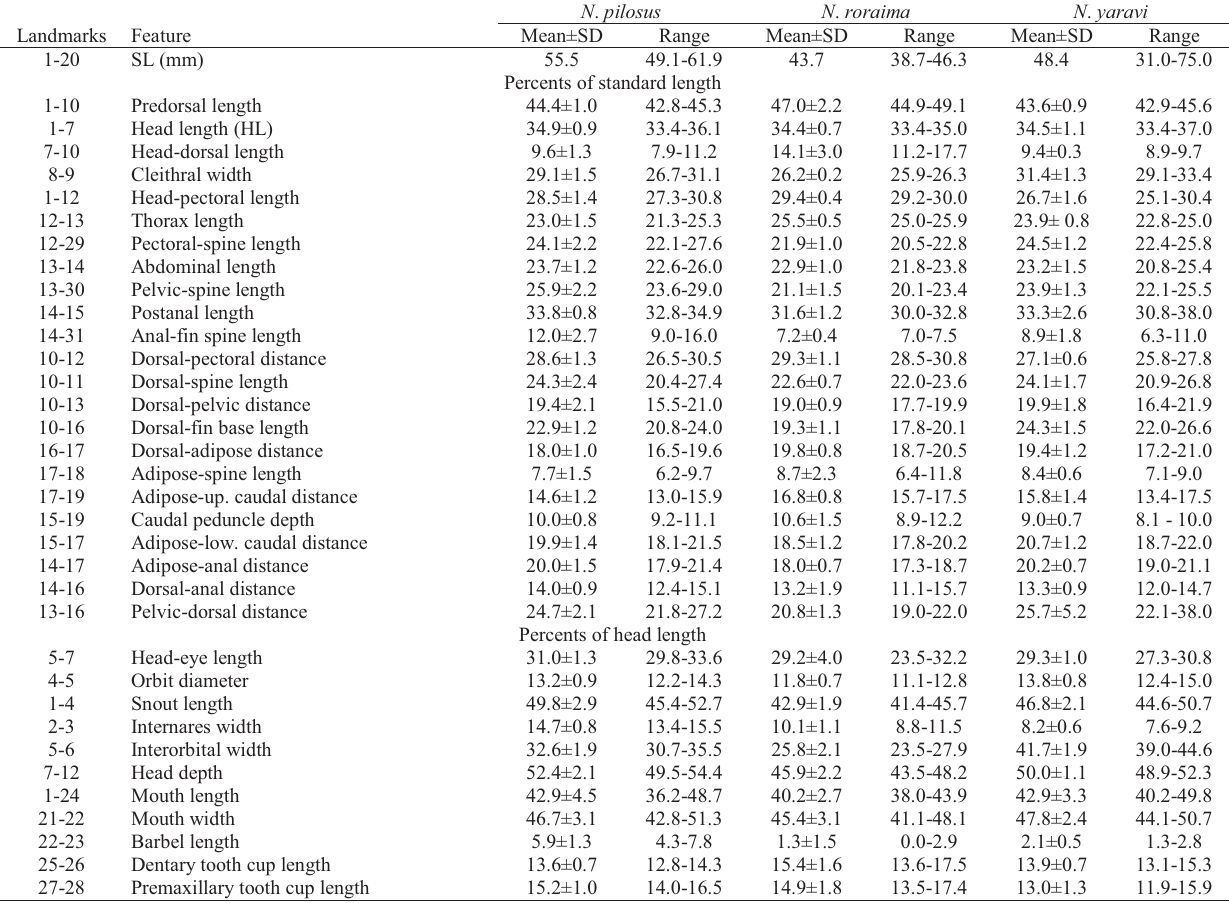
Table 2. Morphometric features of Neblinichthys pilosus (N = 6), N . roraima (N = 4), and N . yaravi (N = 8). Landmarks are the numbered landmarks in Armbruster (2003). Some N . roraima have completely adnate barbels, resulting in a measurement of zero for barbel